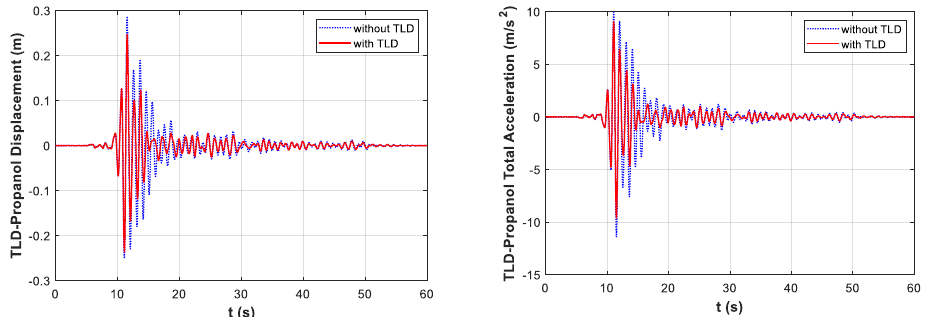
Figure 7. AHS optimization of the single-story structure displacement – time and total acceleration – time graphs in the DUZCE/BOL090 earthquake record for TLD – propanol.